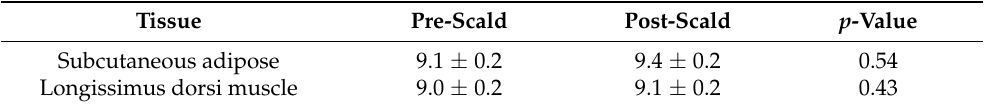
Table 3. RNA integrity number by sampling group in total RNA samples extracted from subcutaneous adipose and longissimus dorsi muscle tissue 1,2